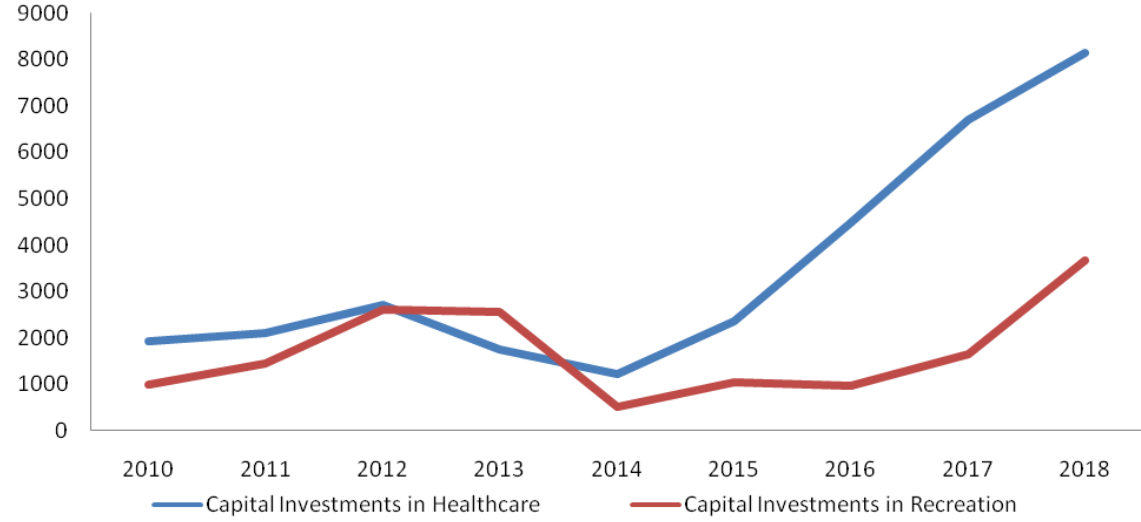
Figure 1. Capital investment in recreation and healthcare in Ukraine, UAH